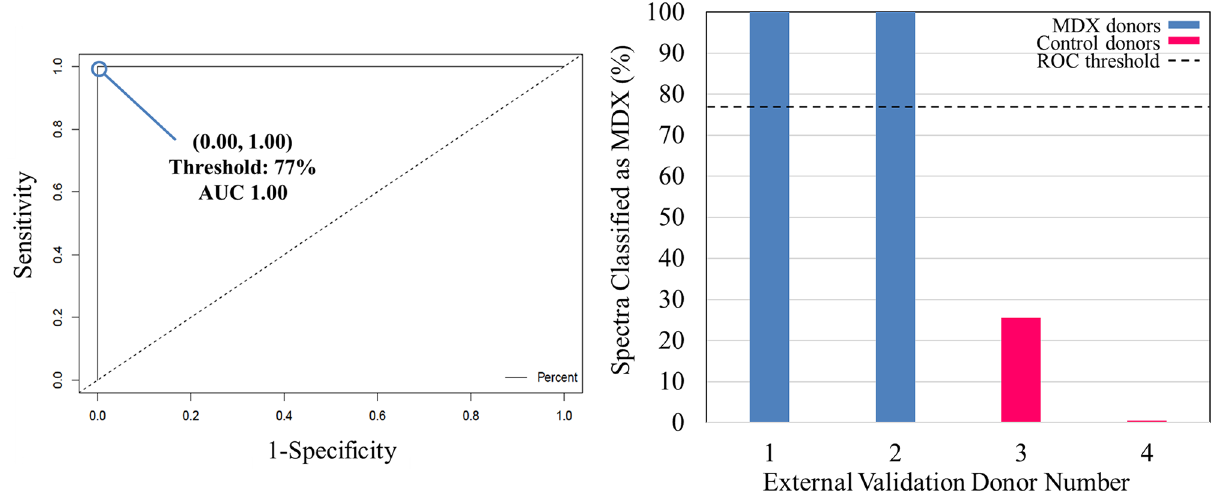
Figure 4. Receiver operating characteristic (ROC) curve and PLS-DA external validation results. ( A ) ROC curve for the cross-validated PLS-DA model, trained to differentiate between diseased and healthy control mice blood serum. The true positive rate (sensitivity) of each potential discrimination threshold are plotted according to each corresponding false positive rate (1—specificity). The optimal threshold is designated by the point at (0.00, 1.00), corresponding to a threshold of 77%. ( B ) The percentage of spectra classified as MDX is plotted as the bar height of each of the donors. The 77% threshold is plotted as the dashed